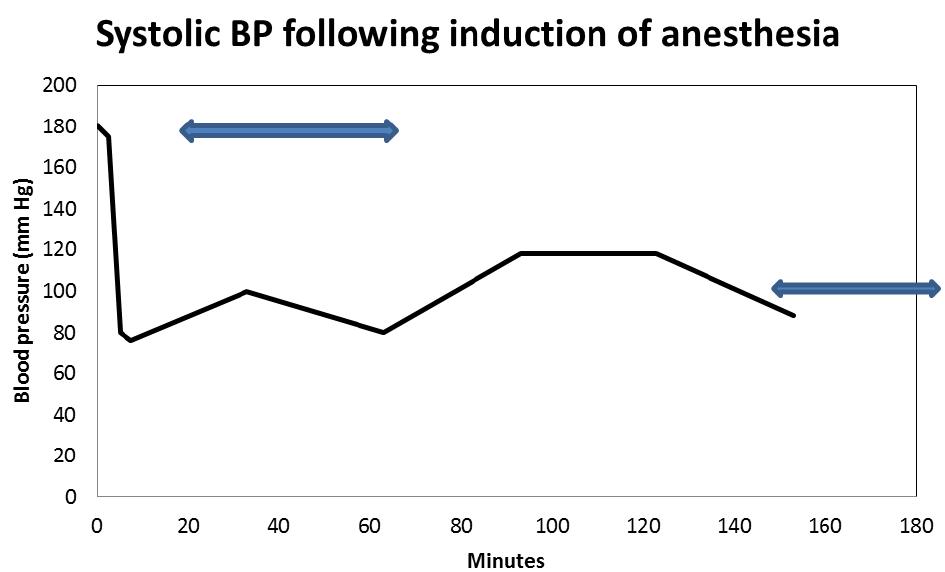
Figure 11. Intra-operative systolic blood pressure translations after induction of anesthesia during elective ablation procedure for symptomatic atrial fibrillation.